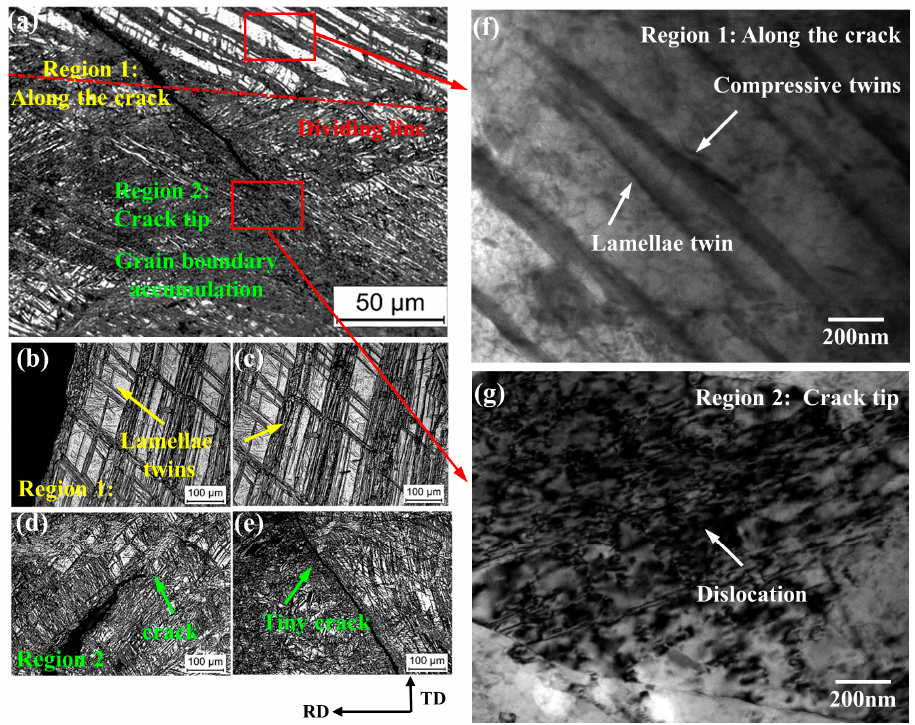
Figure 2. ( a – e ) Microstructure near the edge cracks of the sheet with cracks. TEM image showing the feature of lamellae twins in the ( f ) region 1 and ( g ) region 2.